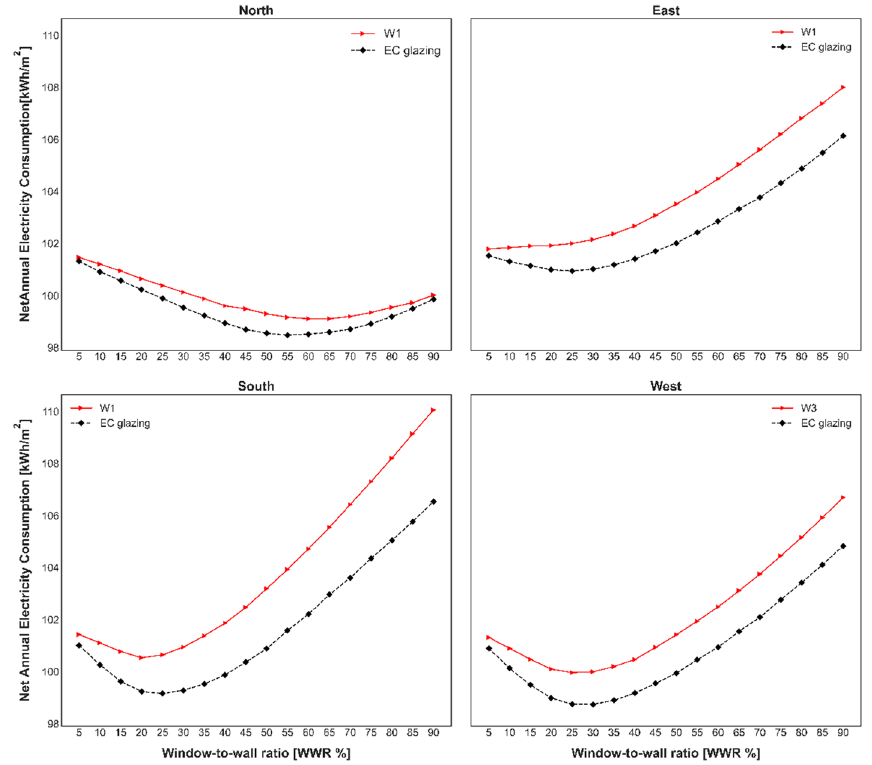
Fig. 8 Comparison of net annual electricity consumption of EC glazing with standard